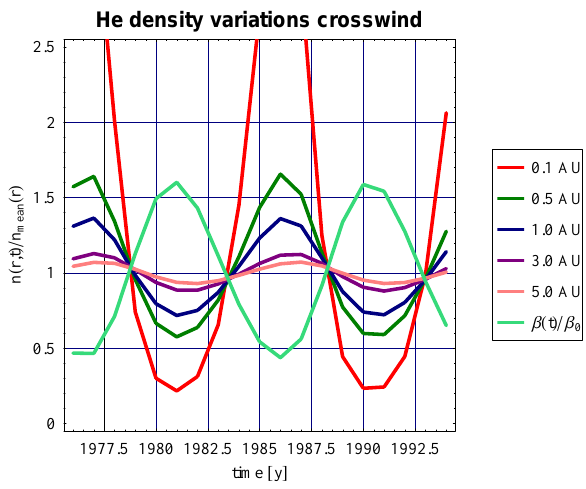
Fig. 5. Deviations of helium density from the mean at the crosswind axis; see caption to Fig. 4.